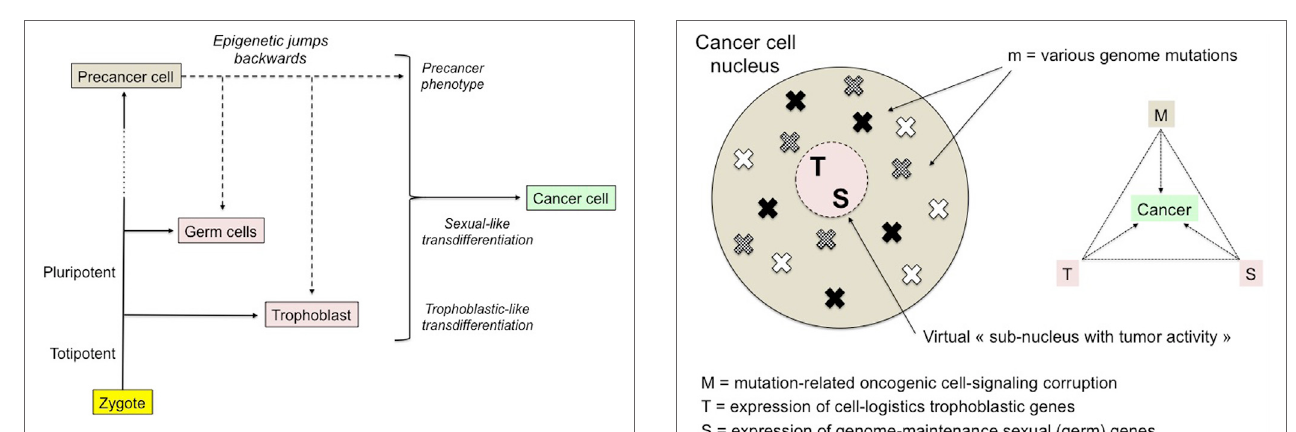
FigUre 3 | The malignant triumvirate. Malignancy is supposed to be the result of the convergence of three anomalies: mutations (and related signaling corruption), and resurgent expression of trophoblastic and sexual master genes. M is variable and determines the multiplicity of cancer processes whereas T and S are fixed actors of the disease. Trophoblastic and sexual genes may be considered as components of a virtual “malignant subnucleus” tightly neutralized in normal cells. Its infinitely low-probability—and so far unexplored—more or less progressive “reactivation” is supposed to be the optimal way for cancer cells to acquire the necessary multi-function support to survive and